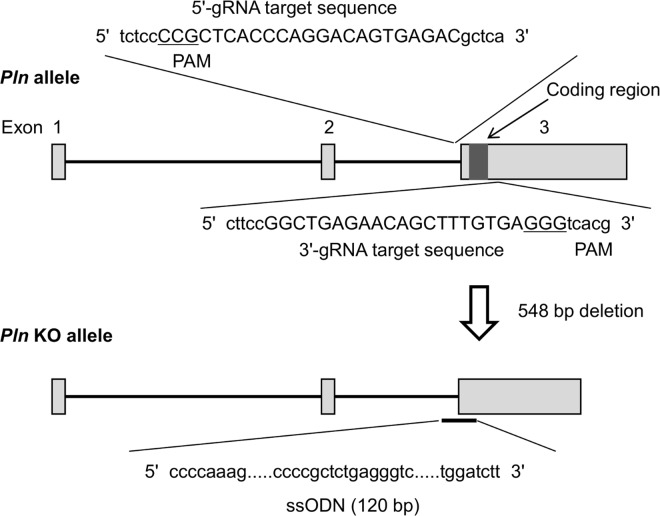
sgRNAs and ssODN targeting Pln coding region.Targeting sequences of each sgRNA are capitalized and NGG PAM (protospacer-adjacent motif) sequences are underlined. Exons are indicated by closed boxes. The sgRNA targeting sites were designed to sandwich Pln coding region (filled with black). The ssODN is containing homologies of 60 bases on both sides flanking each of the sgRNA targeting sequences.